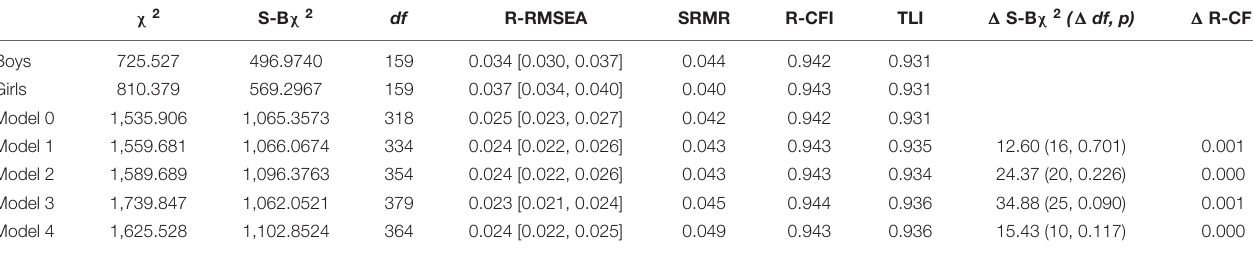
TABLE 5 | Goodness-of-fit indexes for CSAS-P depending on child’s gender. χ 2